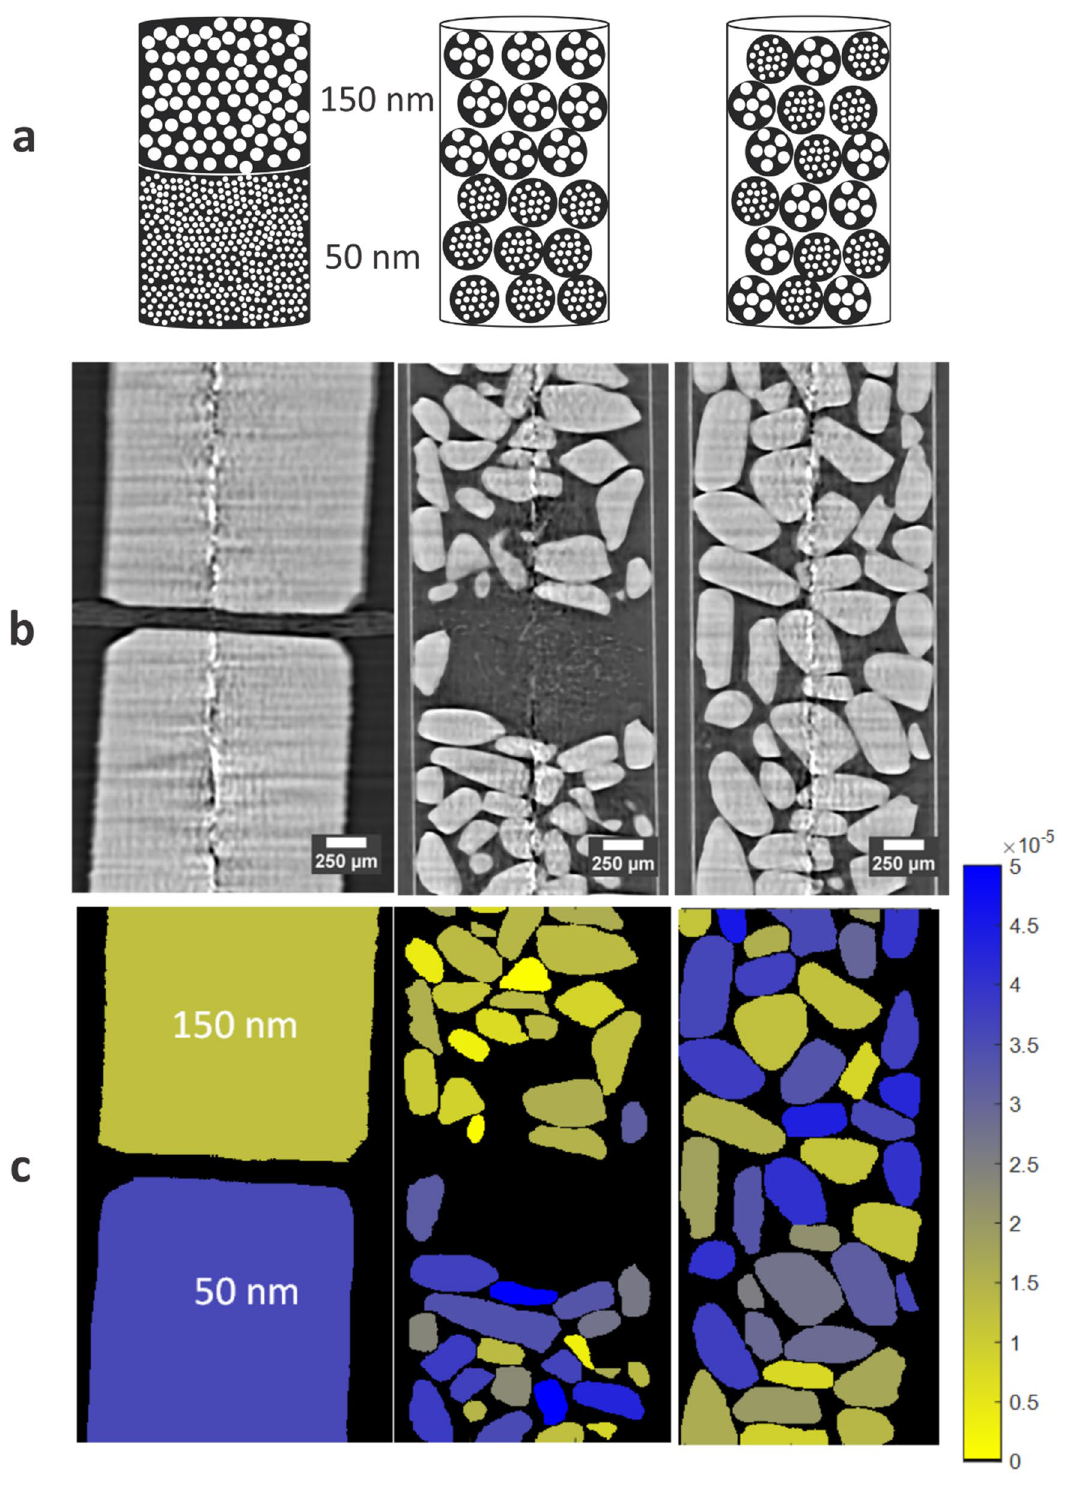
Figure 10. ( a ) Schematic representation of each studied sample. ( b ) Vertical cross-section through the absorption datasets, where no contrast is observed. ( c ) Segmentation where every disk or particle is assigned a color based on its AFS